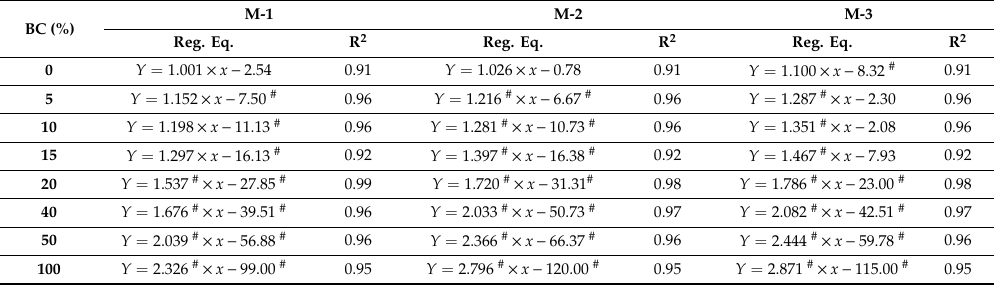
Table 4. Regression equations (Reg. Eq.) and coe ffi cients of determination (R 2 ) between measured and TDR-measured volumetric soil moisture content (VSMC) for studied powdered biochar (BC P ) rates (corresponding graphical representations are given in Figures 2–4).